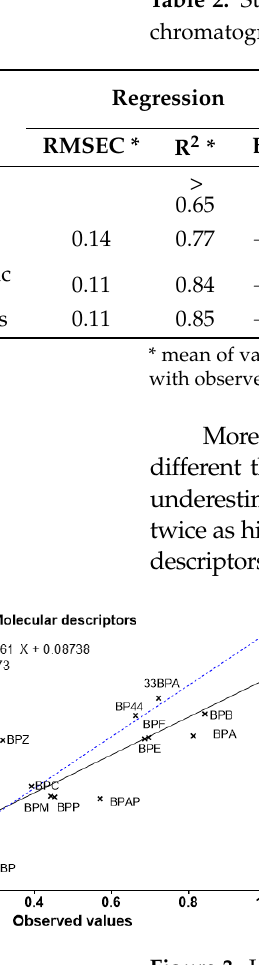
Figure 3. LMO validation curves of the mean observed placental CI of BPs and predicted for the three test data sets by multilinear regression based on molecular ( A ), both molecular and chromatographic ( B ), or chromatographic ( C ) descriptors. The dotted line represents a perfect fit with the equation CIobs = CIpred and the straight line is the representation of CIpred = a × CIobs + b where a and b are the coefficients of the corresponding linear regression model.